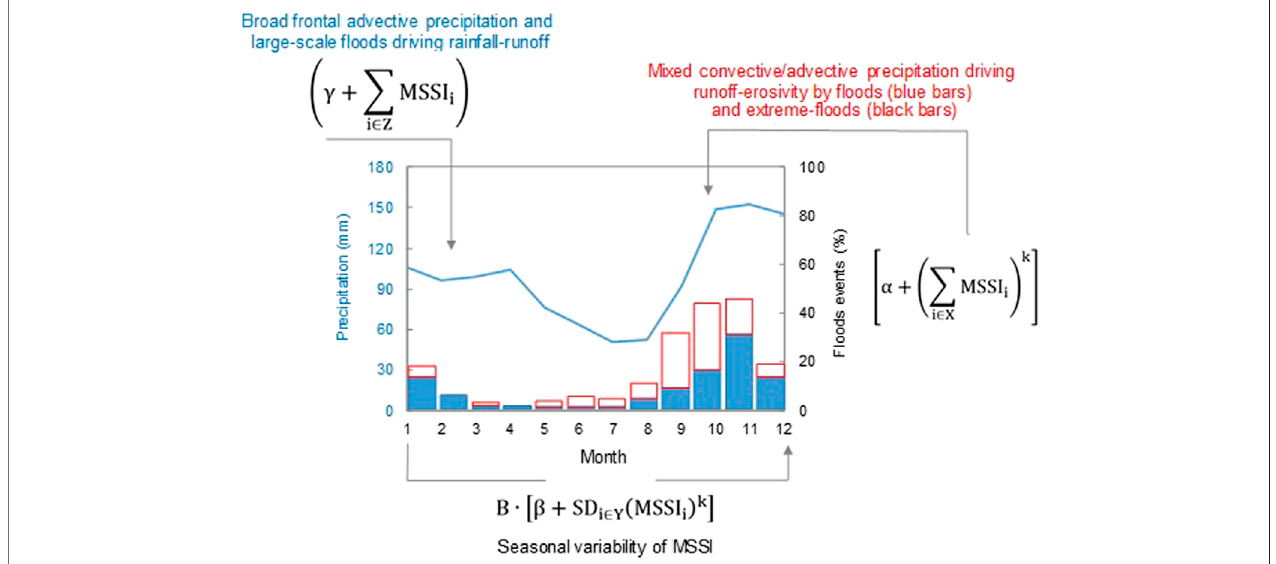
FIGURE 4 | Monthly precipitation and frequency of fl oods and extreme fl oods (1940 – 2015) over the Arno River Basin. Monthly rainfall totals (blue line) are from GPCC (Global Precipitation Climatology Center) by 0.25 ° monthly land-surface precipitation dataset (Schneider et al., 2018). Percentages of monthly fl oods (white, red- contoured bars) and extreme fl oods (blue, red-contoured bars) are from this study and Gaume et al. (2018), respectively. The terms of Eq. 2 are